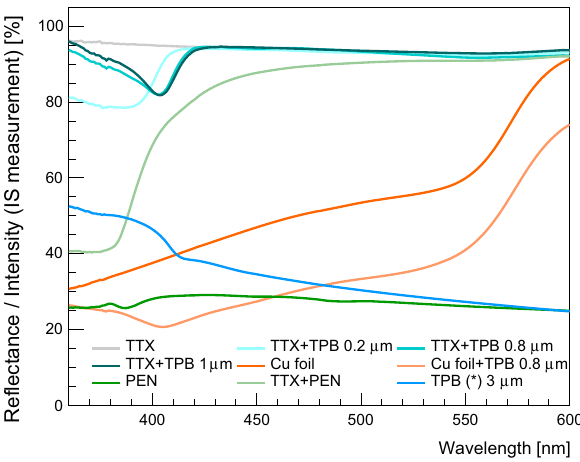
wavelength ( λ i ) from 370 to 590 nm, with a 20nm step. 2 An example is shown in Fig.6, top.